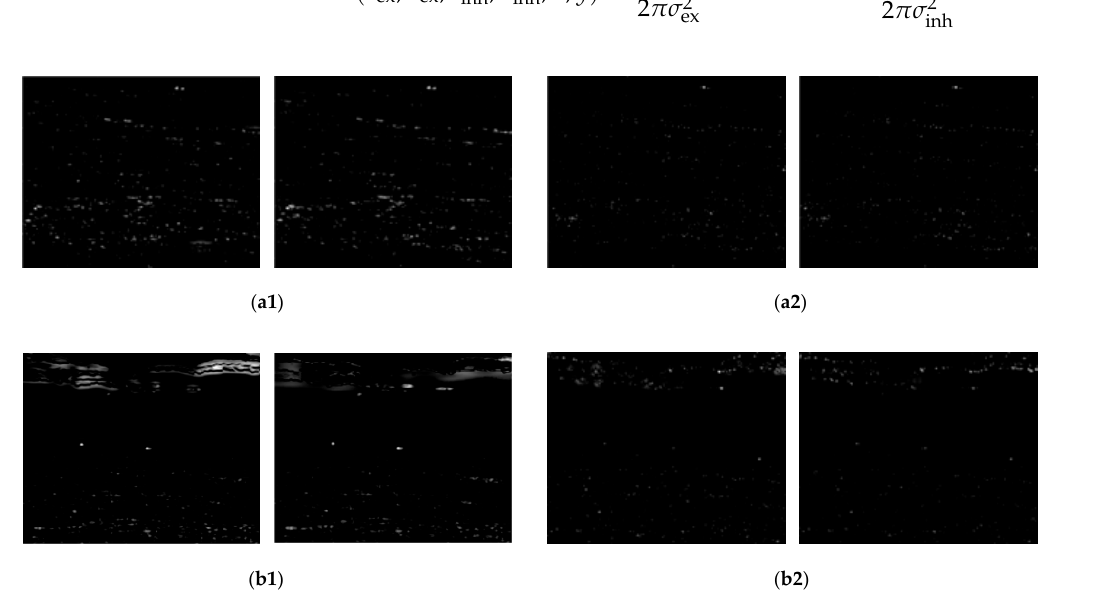
Figure 6. IsD operation results between horizontal and vertical scales. ( a1 ) Inter-scale horizontal texture feature of image A. ( a2 ) Inter-scale vertical texture feature of image A. ( b1 ) Inter-scale horizontal texture feature of image B. ( b2 ) Inter-scale vertical texture feature of image B.